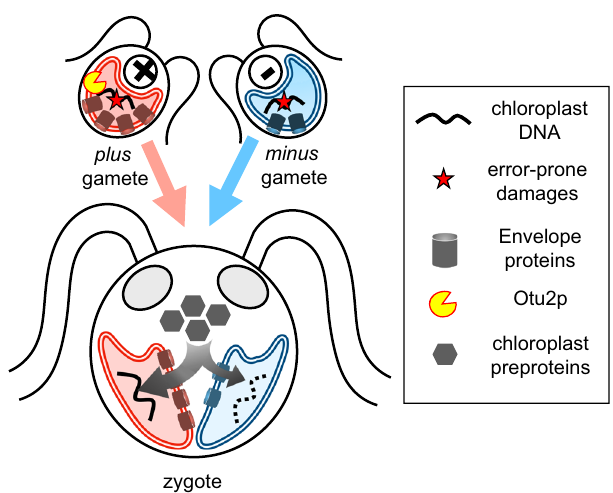
Fig. 6 A model of the OTU2p -dependent mechanism for driving selective cpDNA degradation in zygotes. The model postulates gametes accumulating error-prone damages in cpDNA under nitrogen starvation. Mating-type-linked deubiquitinase OTU2p (yellow shape) prevents proteasome-mediated degradation of envelope proteins (barrel shape) including TOC translocase in plus gametes but not in minus gametes lacking Otu2p. This creates a visible disparity between plus and minus chloroplasts (double-lined cup shape), which leads to a biased fl ow of repair components including zygote-speci fi c chloroplast-targeted preproteins (hexagons) between two chloroplasts combined in a zygote, triggering rapid cpDNA degradation (dotted wiggled line) in minus chloroplast delayed for importing repair safeguards. Therefore, the evolution of OTU2p would be adaptive for improving the quality of plus cpDNA and consequently for driving robust uniparental cpDNA